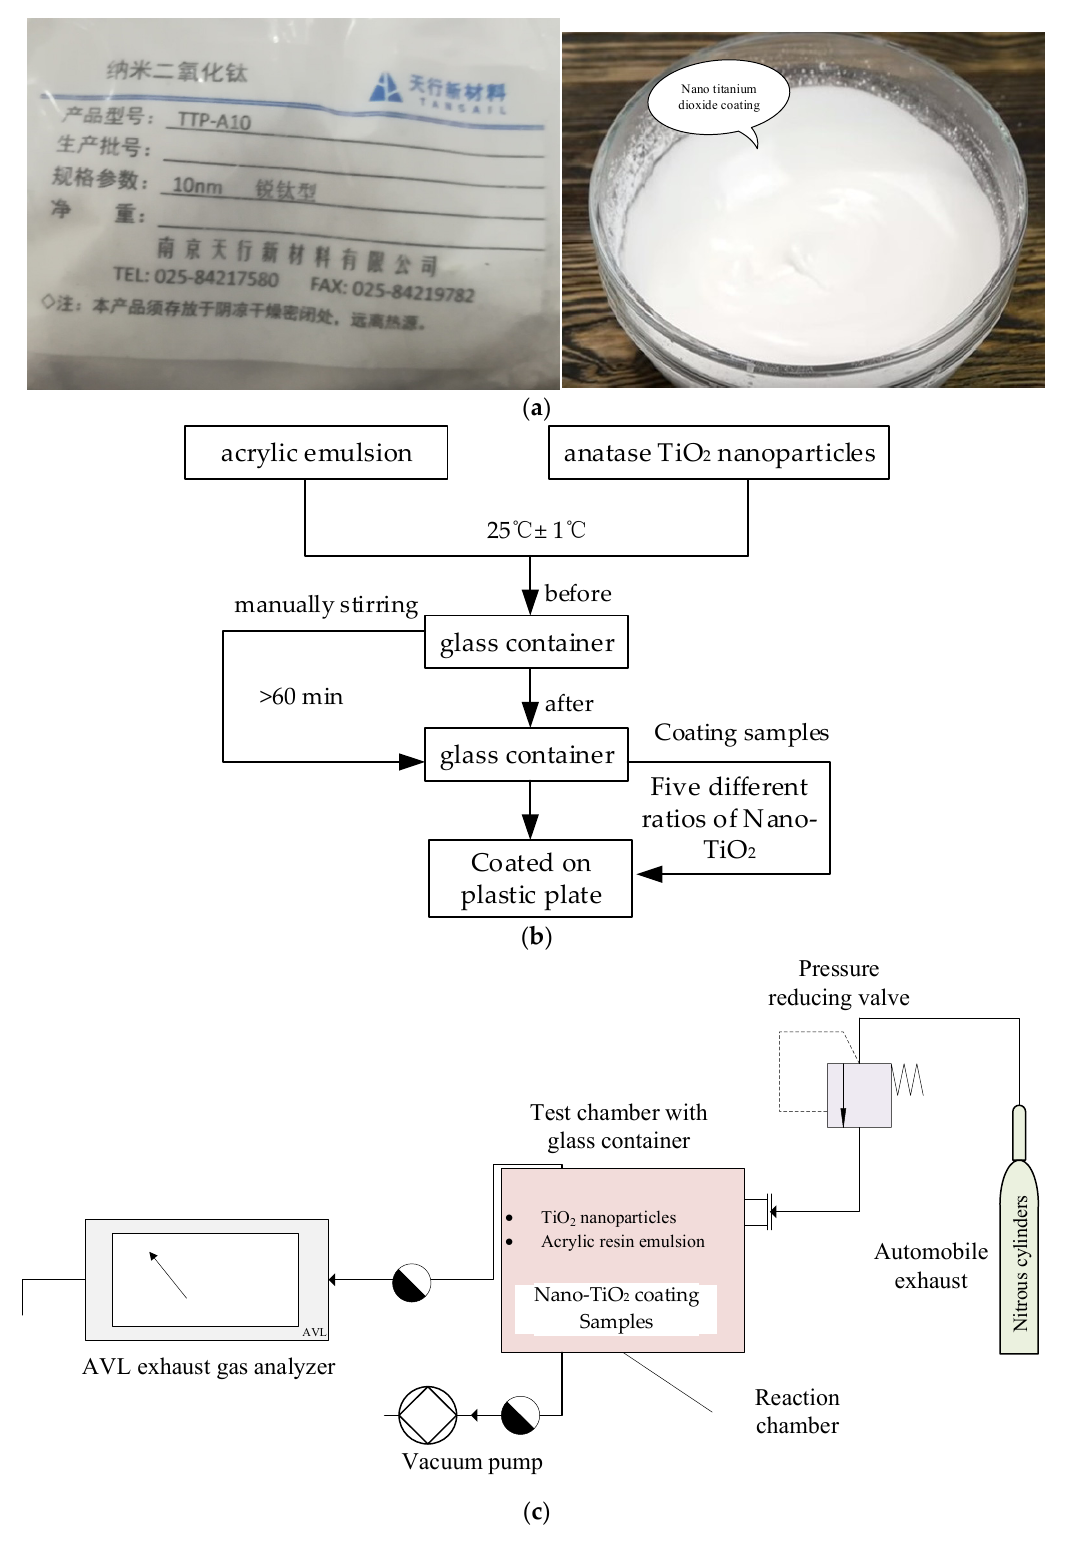
Figure 4. Test devices and mixing process for degradation effect of nano-TiO 2 coating material. ( a ) Critical materials (Left: anatase Nano-TiO 2 particles; Right: Nano-TiO 2 coatings). ( b ) Mixing process flowchart of coating samples. ( c ) Devices connection in the laboratory.